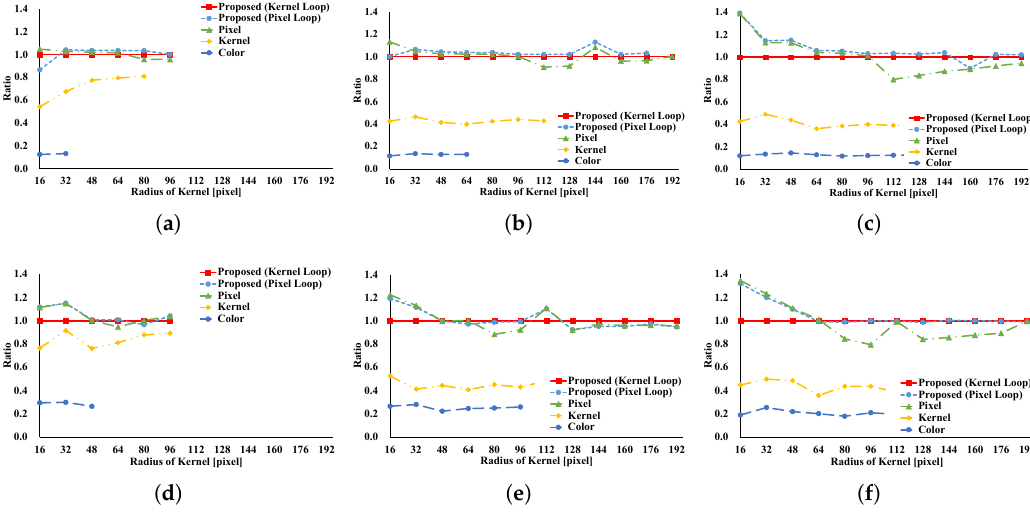
Figure 11. The speedup ratio of bilateral filtering (BF) with respect to the kernel radius of FIR filtering. ( a ) Full sample in weight computation; ( b ) 1/4 subsample in weight computation; ( c ) 1/16 subsample in weight computation; ( d ) Full sample in LUT; ( e ) 1/4 subsample in LUT; ( f ) 1/16 subsample in LUT. If the ratio exceeds 1, the given pattern is faster than the kernel loop